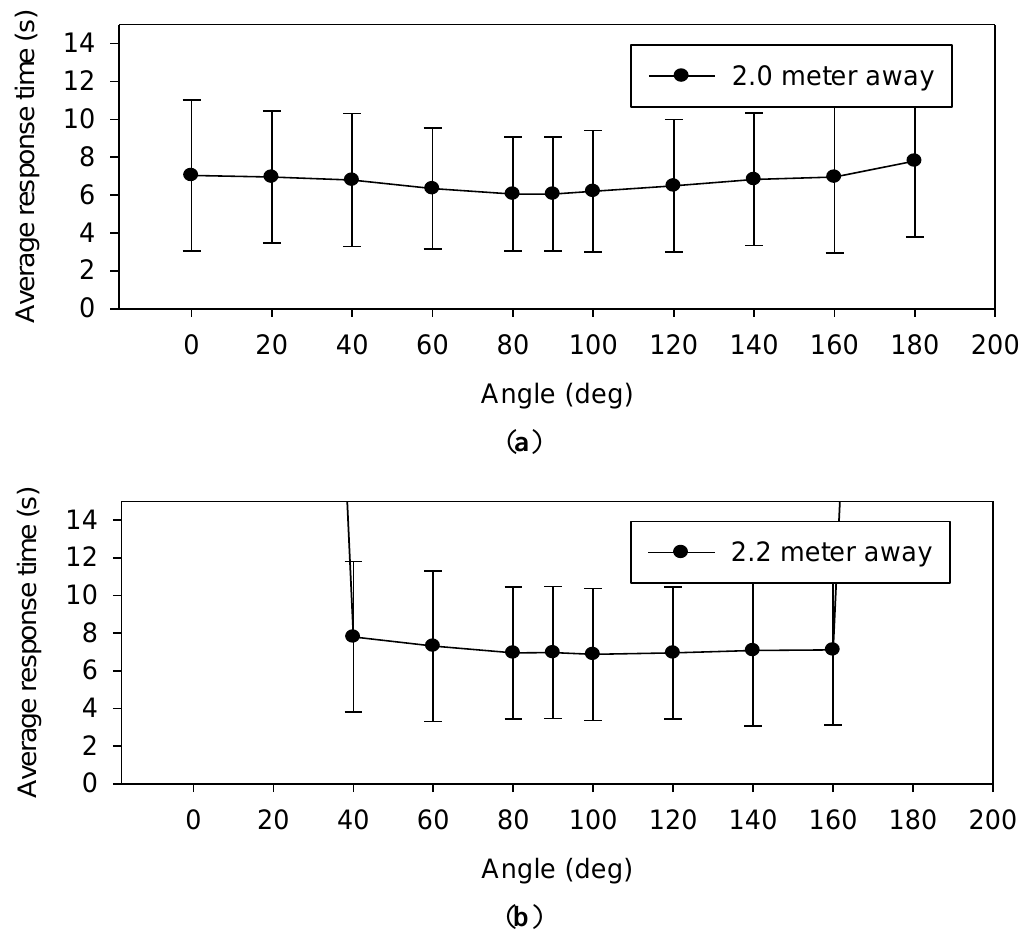
Figure 23. TheWPWSs can form a star topology to construct a sensor network. The average response time of 11 WPWSs distributed at 2 m, 2.2 m and 2.4 m diameter area appear in ( a ), ( b ), and ( c )